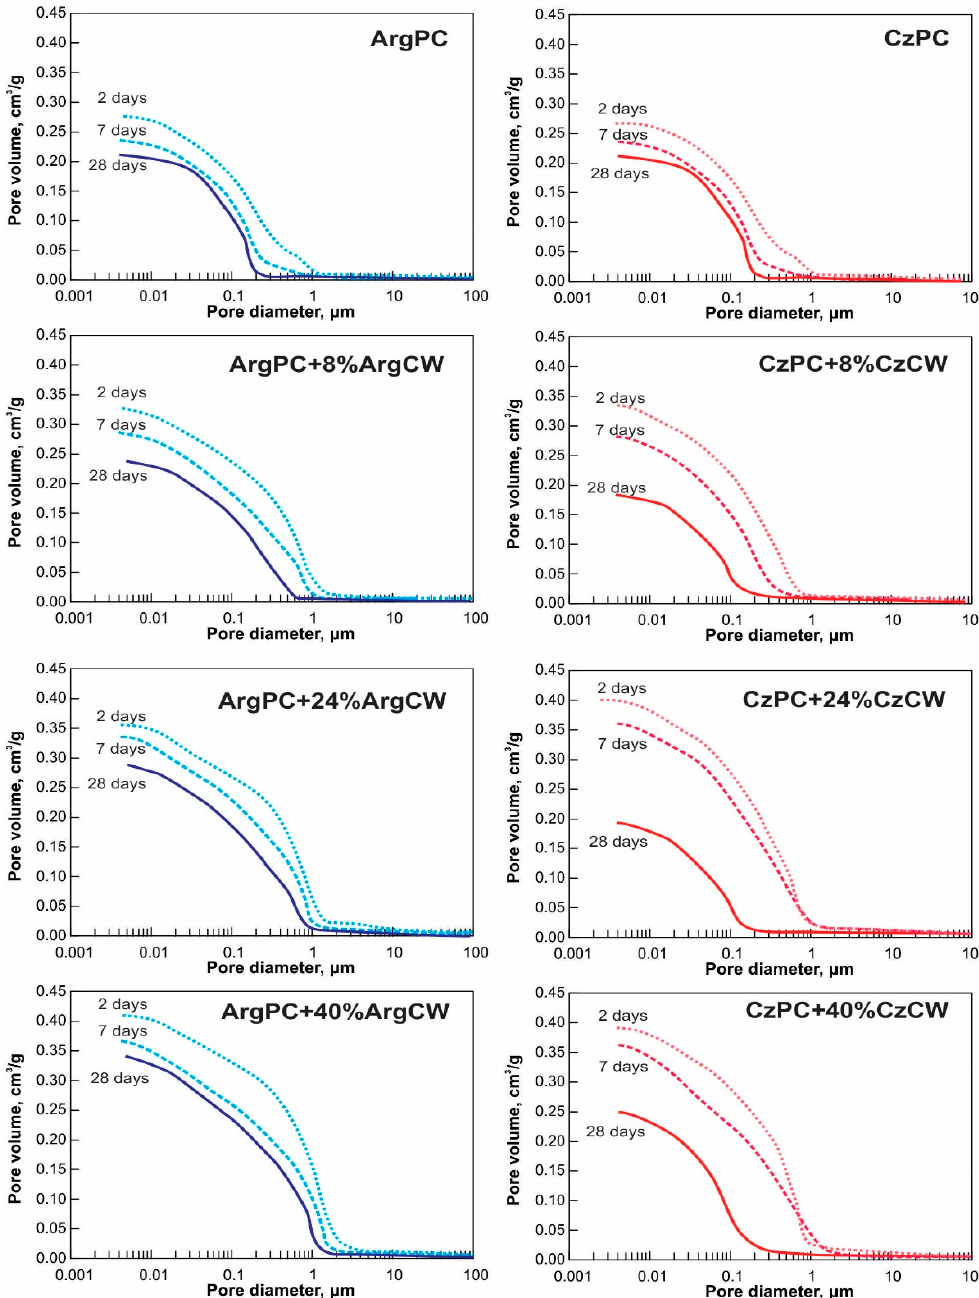
Figure 7. The Pore size distribution of blended pastes.